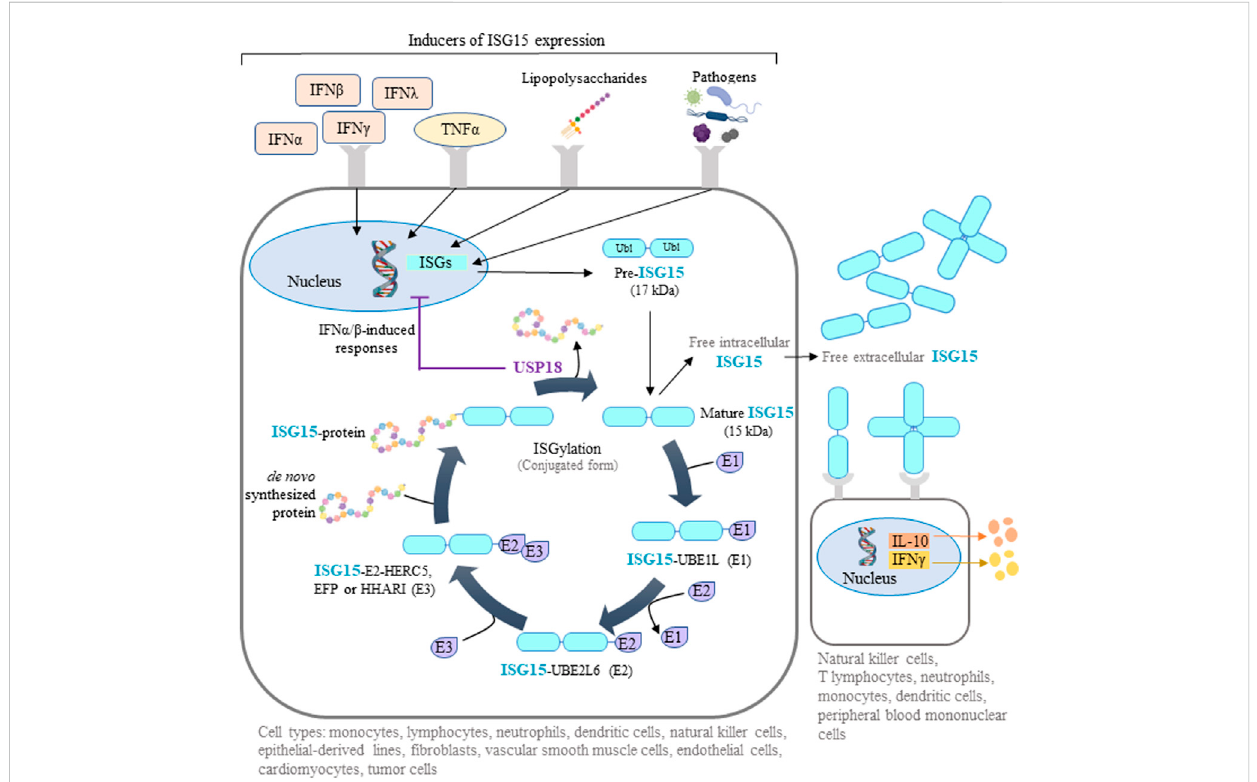
FIGURE 1 ISG15-mediated protein ISGylation. ISG15 is produced as a 17-kDa precursor with two ubiquitin-like domains in response to diverse stimuli, including interferons (IFNs), tumor necrosis factor α (TNF α ), lipopolysaccharides, and several pathogens. Intracellular ISG15 exists either as a free protein or conjugated to de novo synthesized proteins through ISGylation. This post-translational process can be reversed by the action of ubiquitin speci fi c peptidase18(USP18),aproteasethatalsoregulatesIFN-mediatedsignaling.FreeintracellularISG15canbesecretedtoactasacytokine,causingthe release of IFN γ and interleukin 10 (IL-10). Extracellular ISG15 can form dimers and multimers that modulate cytokine levels. Some illustrations were created using